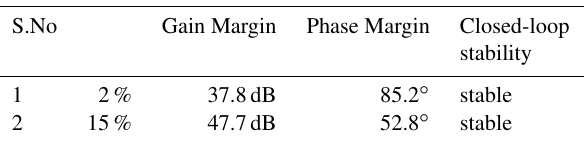
Table 9. Robustness analysis of inlet temperature for 2% and 15% changes in H in .